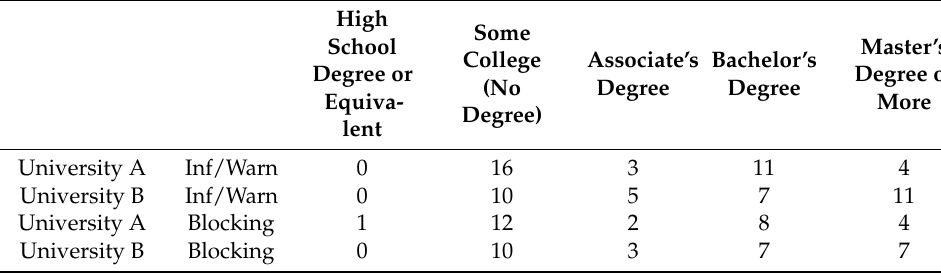
Table 28. Education level of participants in information/warning and blocking